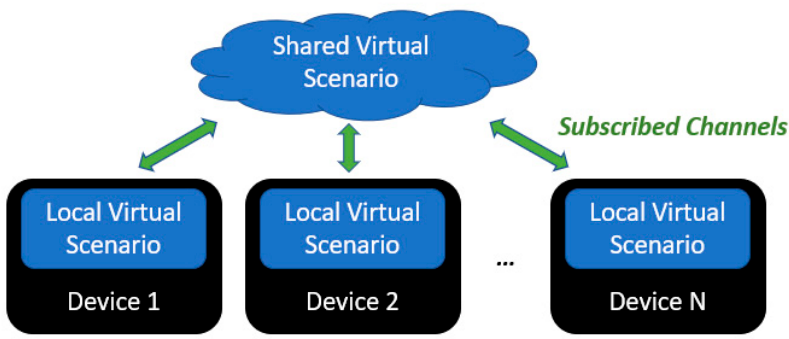
Figure 3. Shared virtual scenario schema.